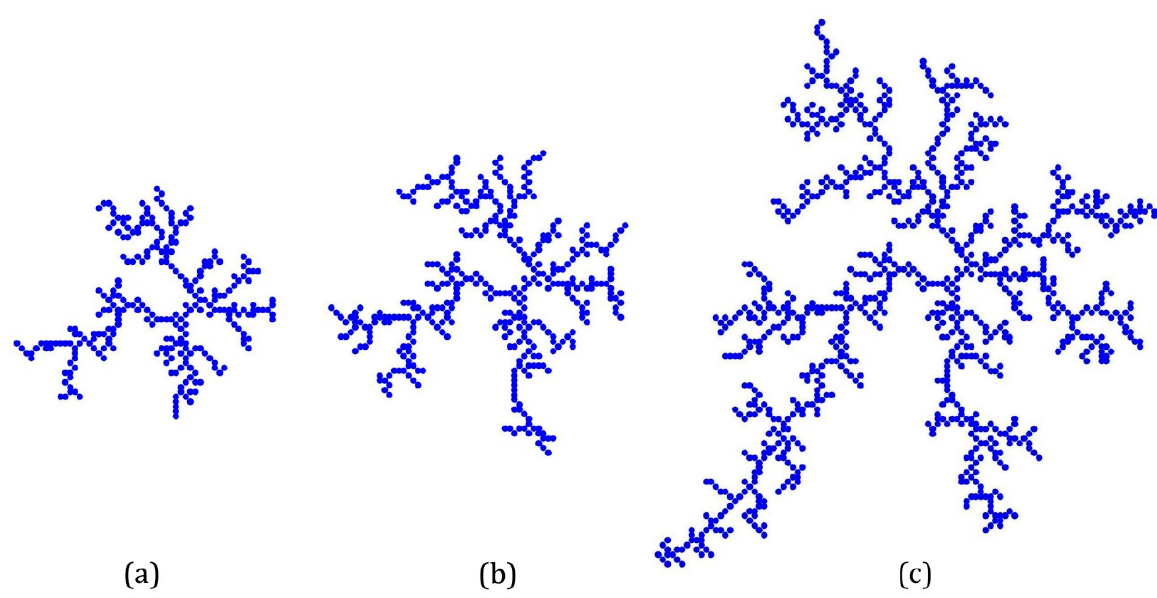
Figure 3. The dendritic pattern simulated by DLA (200 × 200 lattice, 20,000 particles). ( a , b ) the intermediate results of DLA simulation with 8057 particles ( a ) with 10,827 particles (b) ; ( c ) the result of DLA simulation with 20,000 particles.